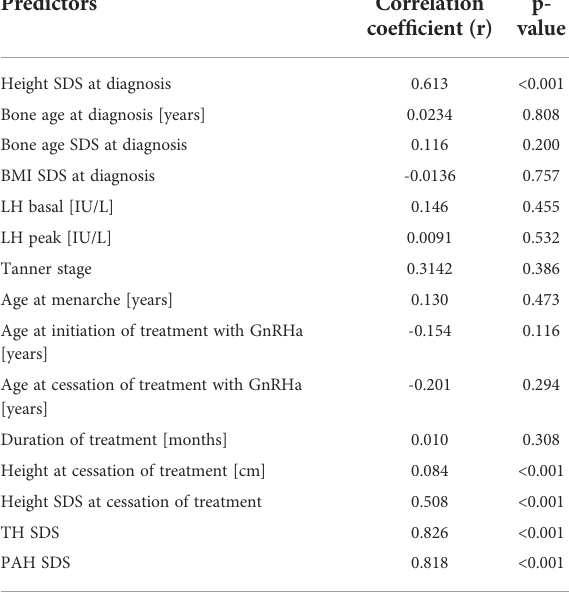
TABLE 7 Univariable analysis of predictors associated with fi nal height SDS in 48 girls treated with